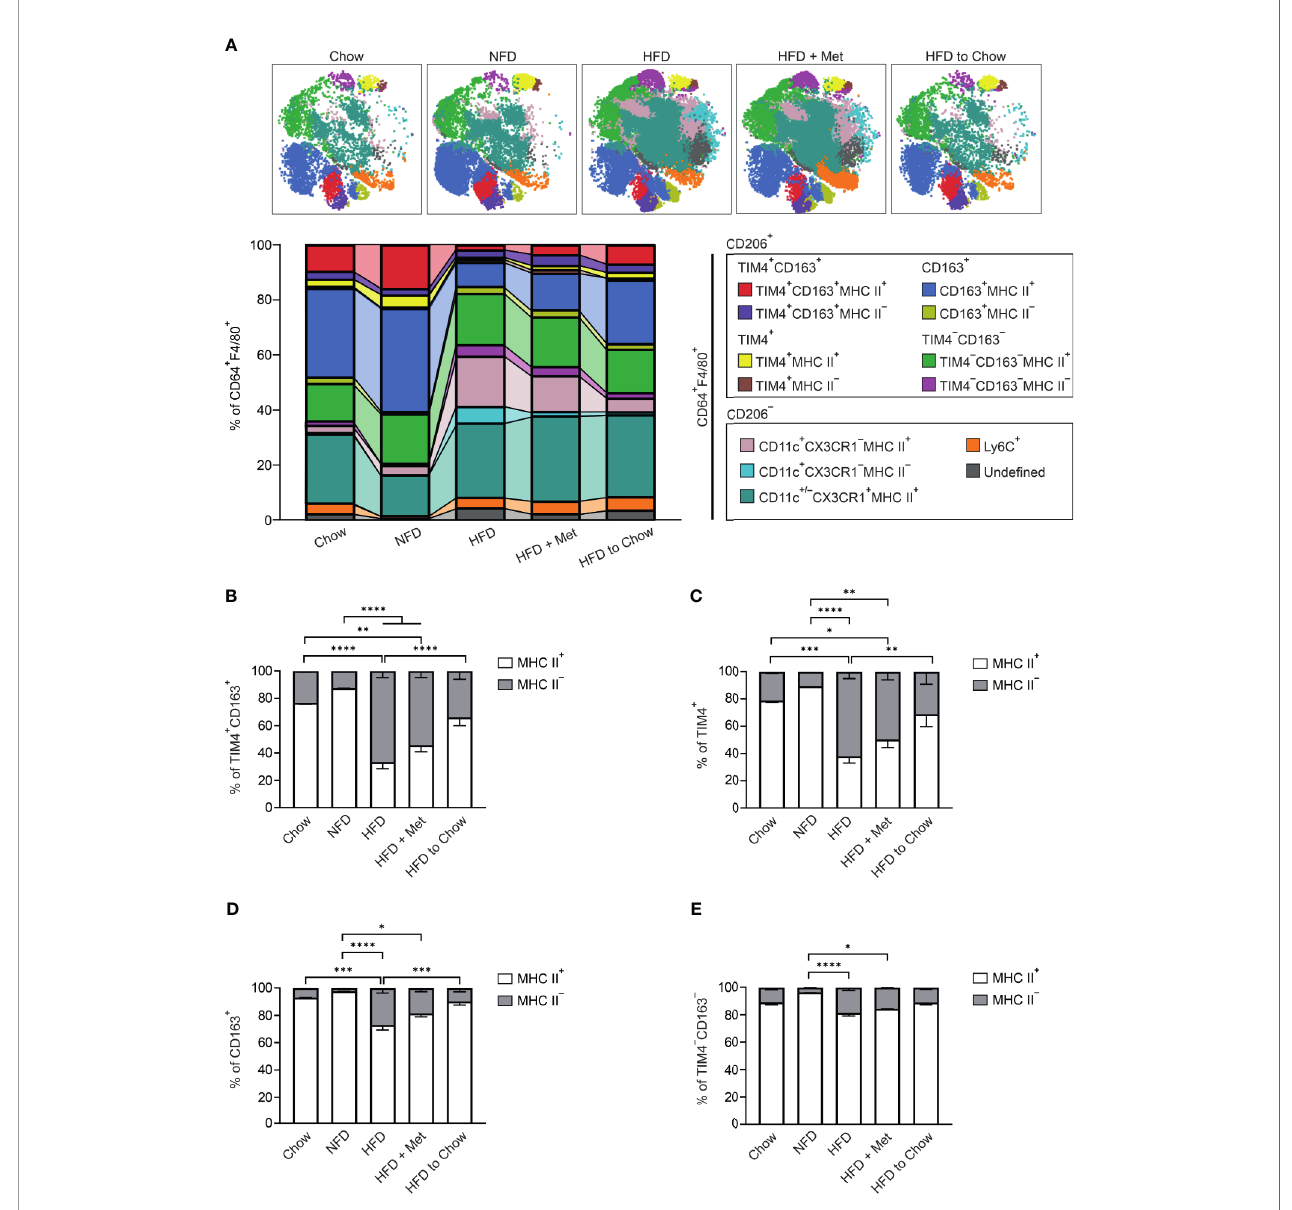
FIGURE 5 | Obesity induces reversible down-regulation of MHC II in resident ATMs. (A) Representative FlowSOM maps and frequencies of CD45 + CD64 + F4/80 + macrophage cell clusters in eWAT of wild type (WT) mice with different dietary interventions; standard diet (Chow), normal-fat diet (NFD), high-fat diet (HFD), or weight loss models; metformin-treated mice on HFD (HFD + Met) or HFD fed mice switched to standard diet after 8 weeks (HFD to Chow). Individual FlowSOM metaclusters (subpopulations) are indicated in different colors. (B – E) Frequencies of MHC II + and MHC II − cells in different ATM subpopulations of mice on different dietary interventions. The quantitative data are shown as mean ± SEM (* P ≤ 0.0332, ** P ≤ 0.0021, *** P ≤ 0.0002, **** P ≤ 0.0001, two-way ANOVA with Bonferroni post-hoc test). All mass cytometry data are from n = 8 (Chow), n = 8 (NFD), n = 16 (HFD), n = 8 (HFD + Met), or n = 10 (HFD to Chow) mice and from 2 independent